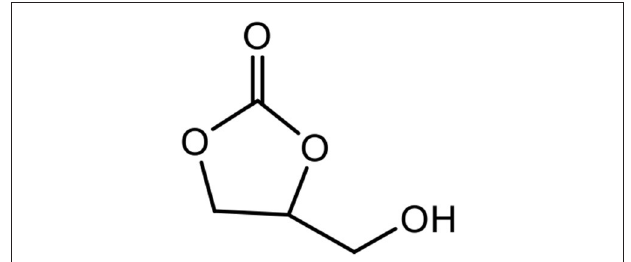
FIGURE 1 | Structure of the glycerol carbonate